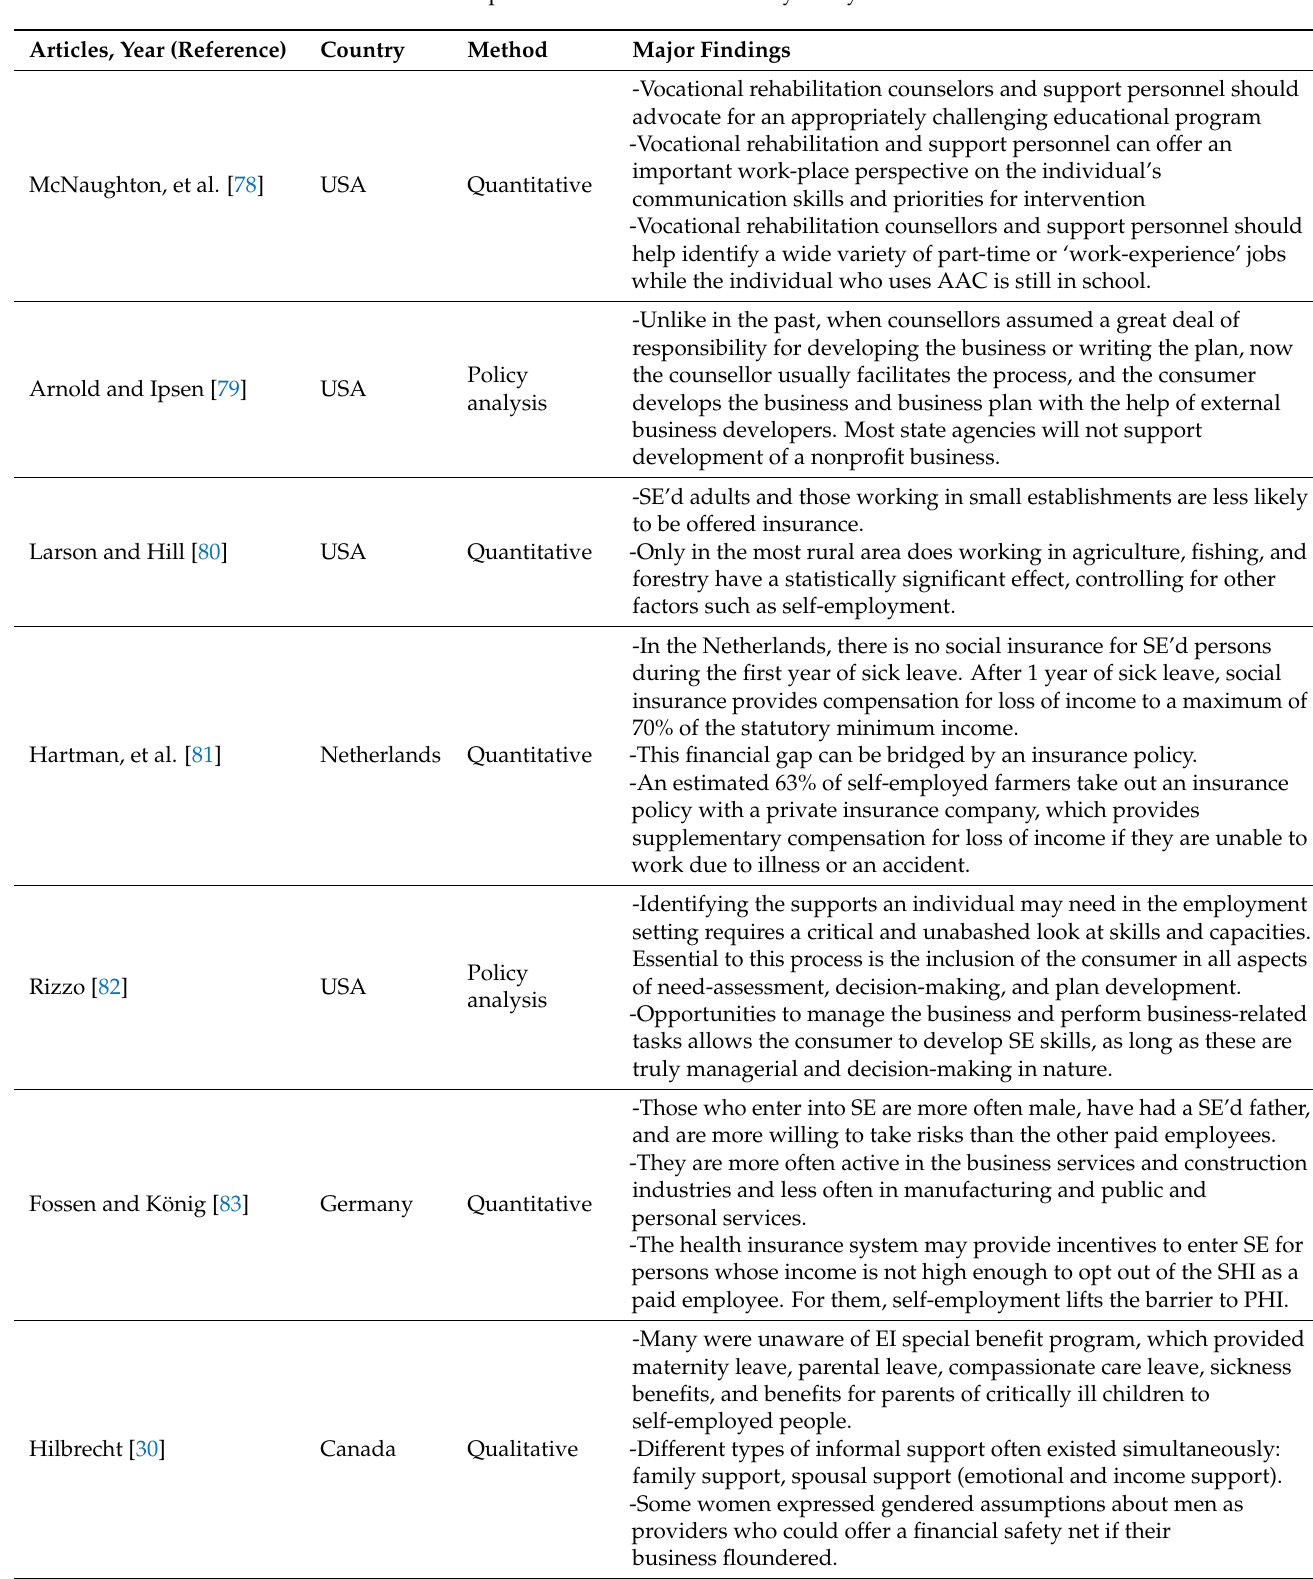
Table 2. Description of literature identified by the systematic